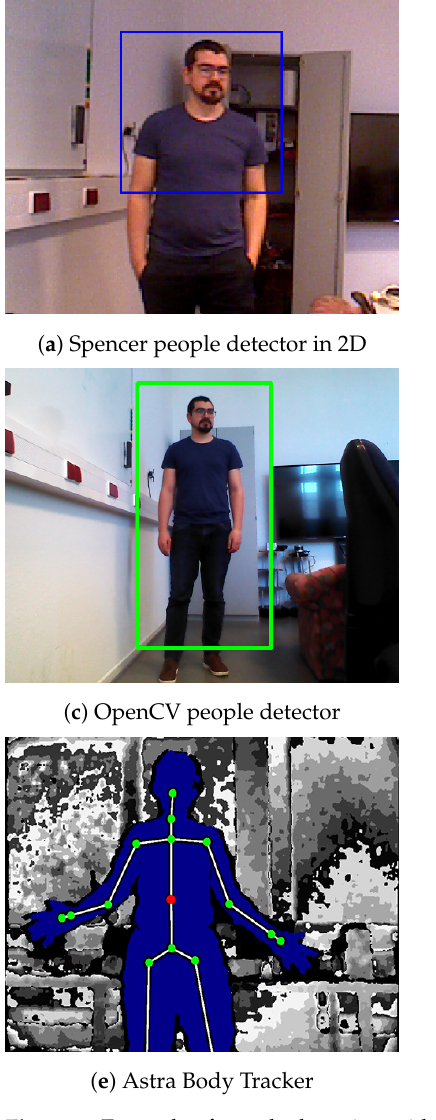
Figure 7. Example of people detection with an RGB-D camera using different